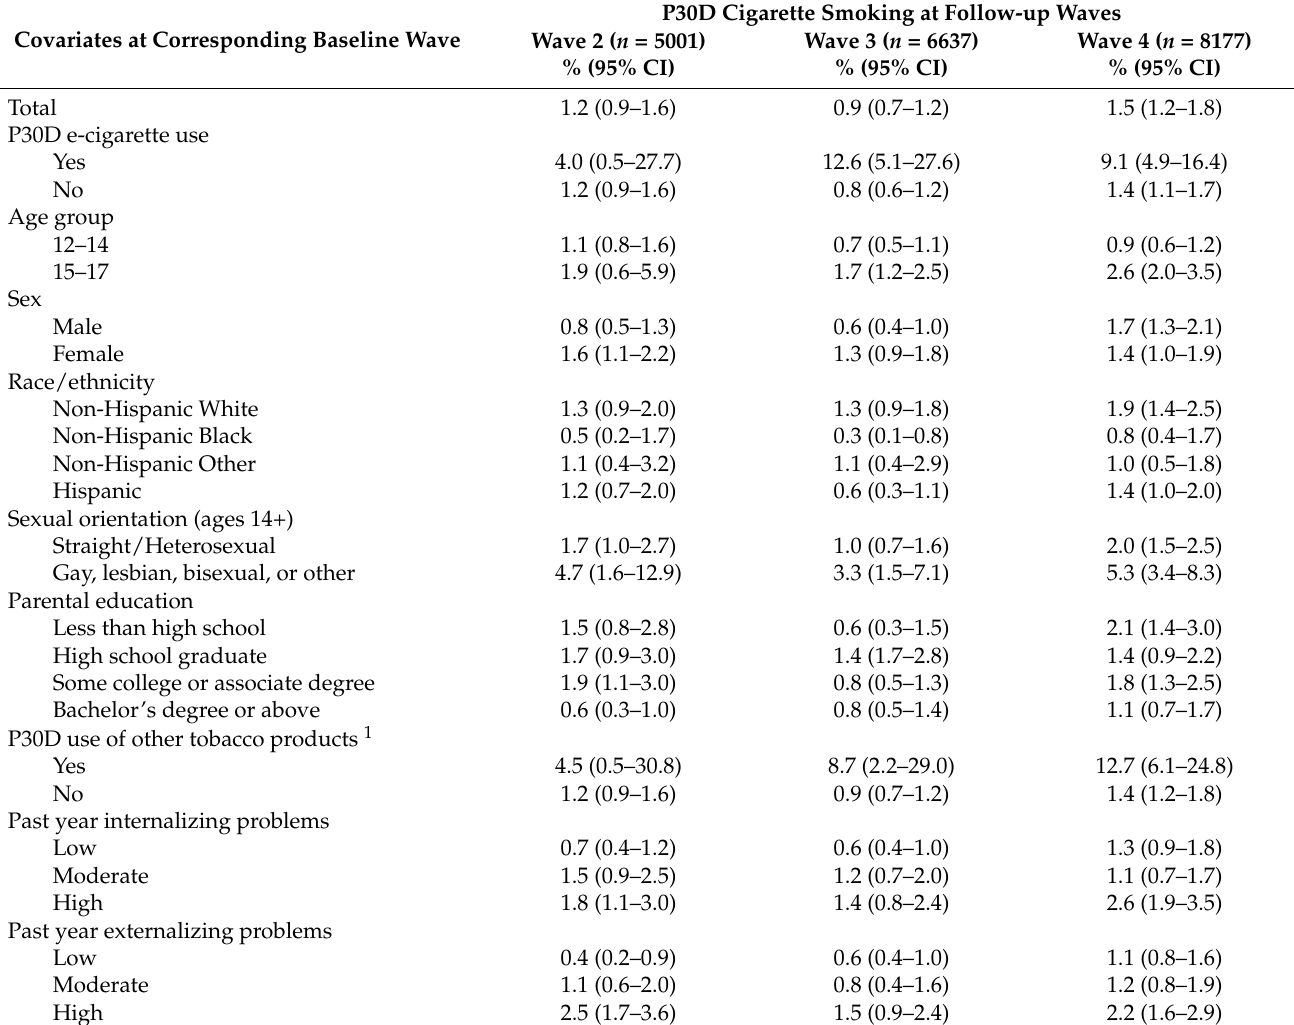
Table 2. Percentage of past-30-day (P30D) cigarette smoking at each follow-up wave by covariates at its corresponding baseline wave among baseline never cigarette